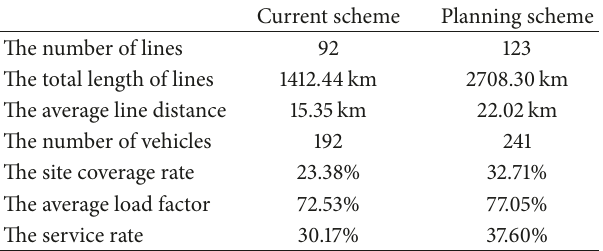
Table 1: Beijing CB network evaluation index contrast.